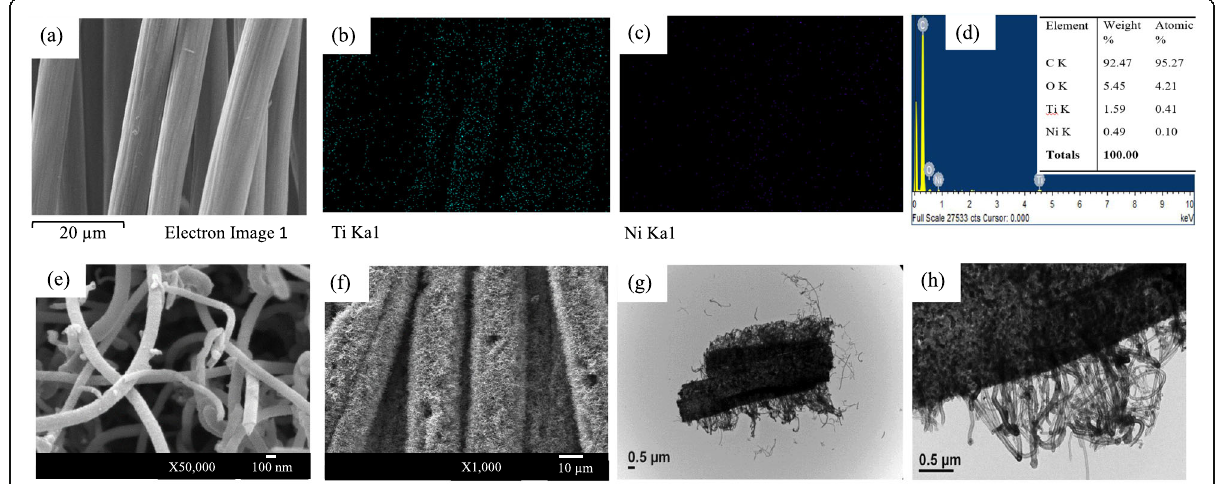
Fig. 3 A SEM image of CF M , B elemental EDX mapping of Ti in CF M , C elemental EDX mapping of Ni in CF M , D EDX spectrum of CF M , E and F CNTs/CF M , G and H TEM image of CNTs/CF